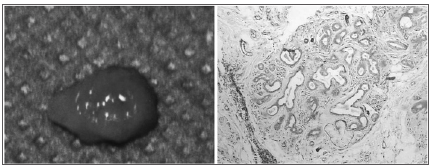
Figura 1. Adenose Policística Esclerosante - Aspecto nodular da lesão após excisão cirúrgica. Na histologia, observar nódulo